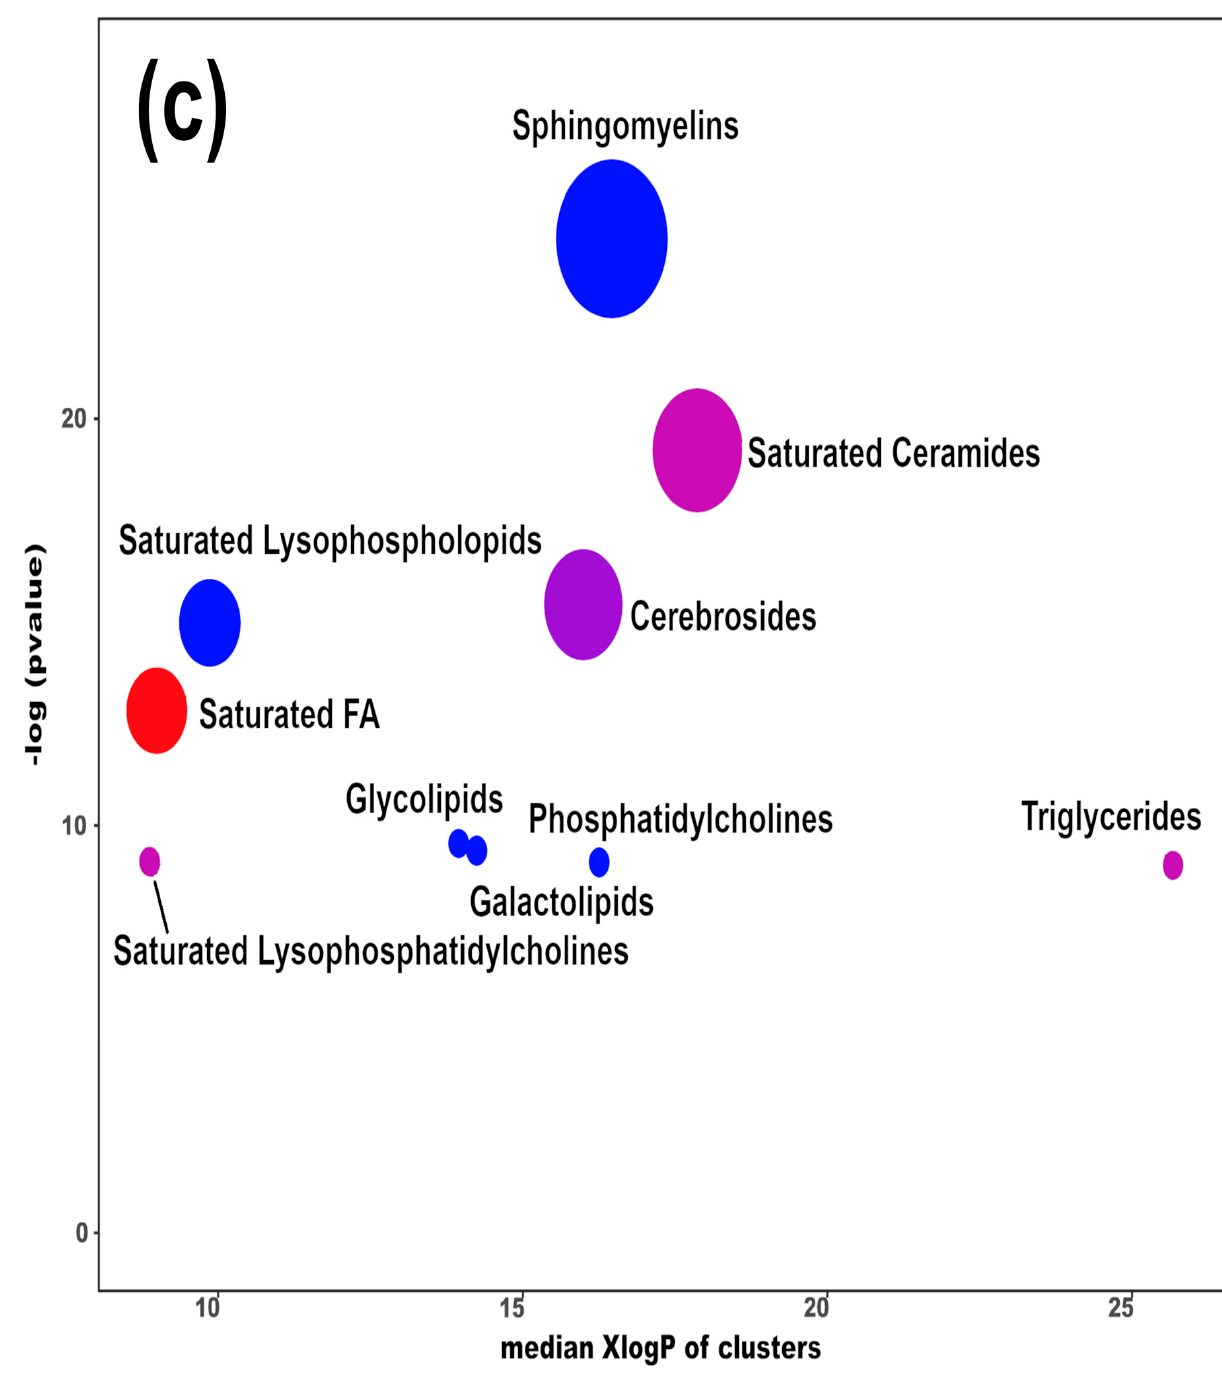
Figure 3. Heatmap ( a ), correlation plot ( b ), and ChemRICH set enrichment statistics plot ( c ) of the concentration of the fatty acids quantified by UHPLC-HRMS/MS in giant panda feces, which showed a statistically significant difference between groups. In the ChemRICH set enrichment statistics plot, each node reflects a significantly altered cluster of molecules. Enrichment p -values are calculated through the Kolmogorov–Smirnov test. Node sizes represent the total number of metabolites in each cluster set. The node color scale shows the proportion of increased (red) or decreased (blue) compounds in the High bamboo shoot consumption group compared to the Normal group. Purple-color nodes have both increased and decreased